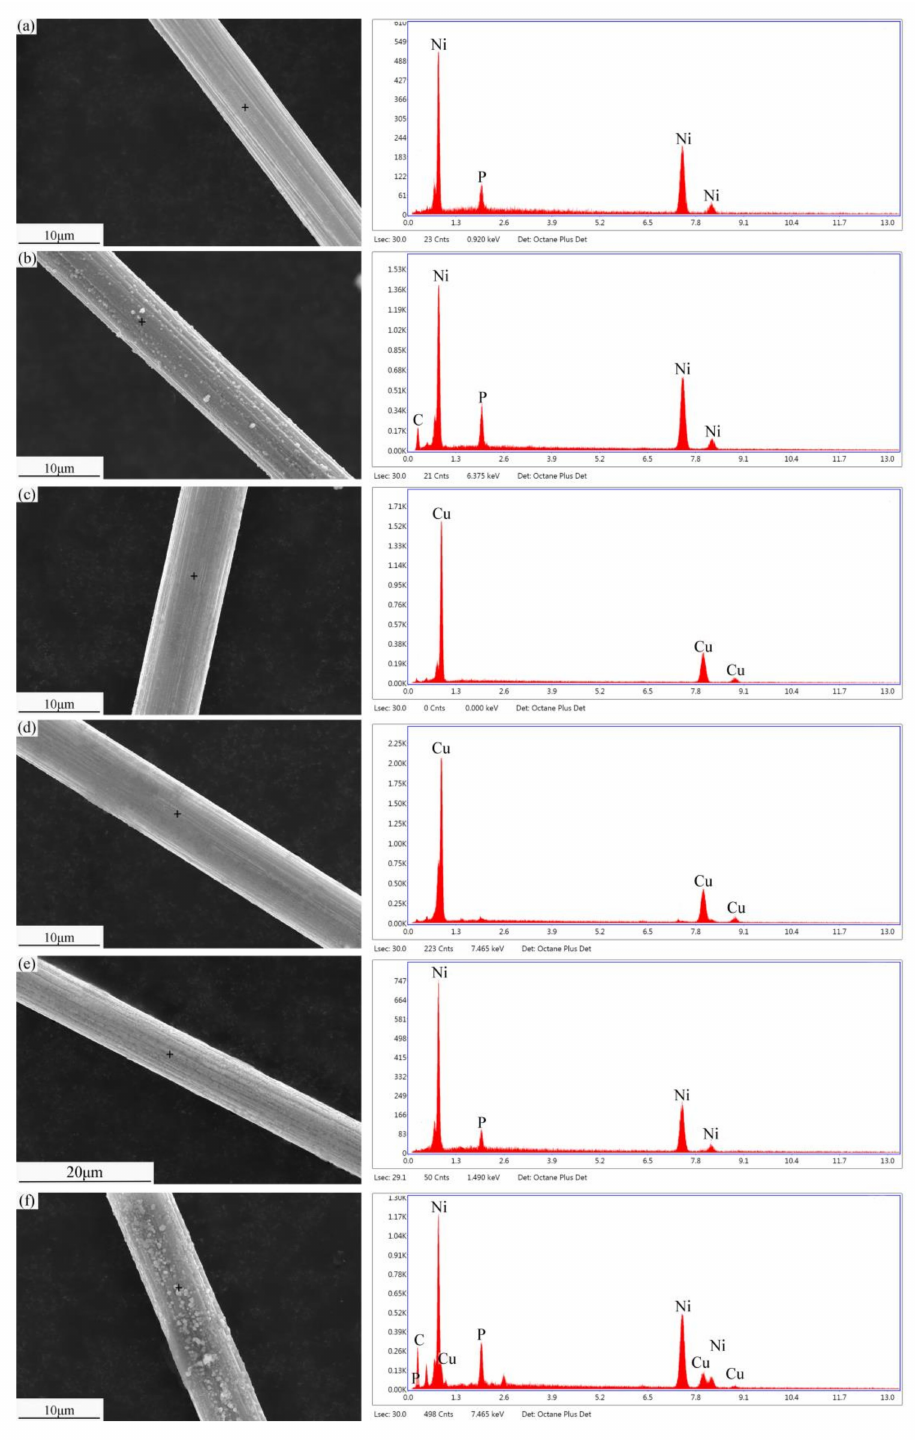
Figure 2. SEM images of surface microstructures of the modified SCFs and energy-dispersive X-ray spectrometry (EDS) images of the modified SCF surfaces: ( a , b ) Ni-Cf; ( c , d ) Cu-Cf; ( e , f ) Cu-Ni-Cf; ( a , c , e ) before heat treatment; and ( b , d , f ) after heat